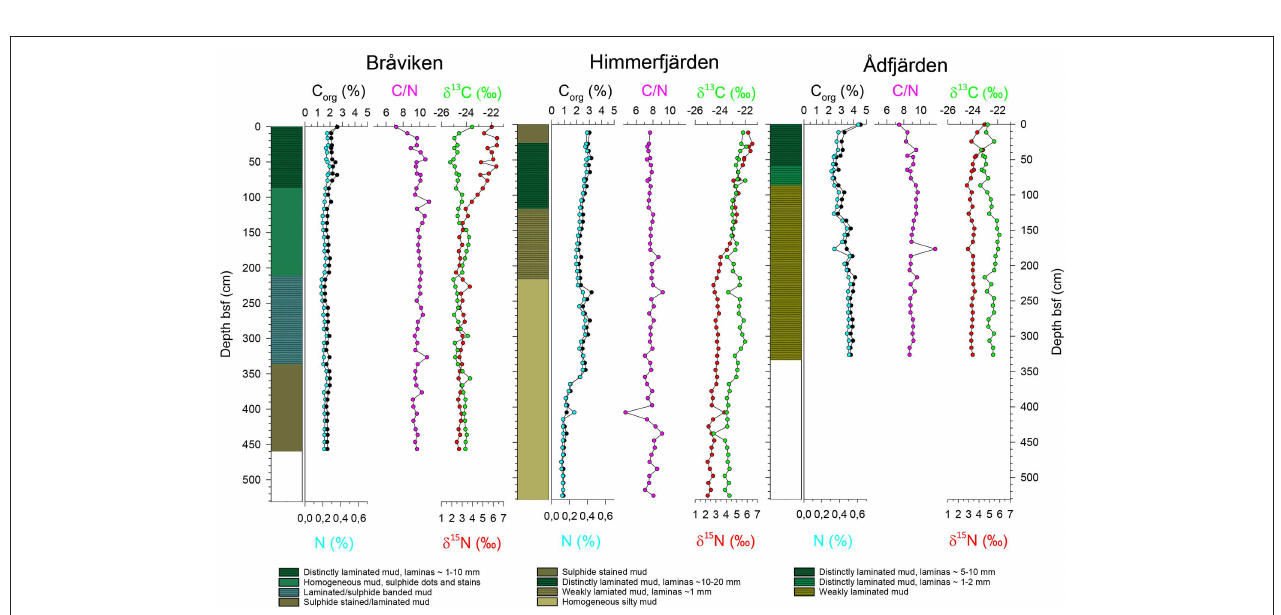
FIGURE 4 | Lithologies and geochemical profiles for Bråviken, Himerfjärden, and Ådfjärden. Geochemistry parameters are organic carbon (C org ), nitrogen (N), organic carbon/nitrogen (C/N) ratio, and stable isotopes of δ 13 C and δ 15 N.